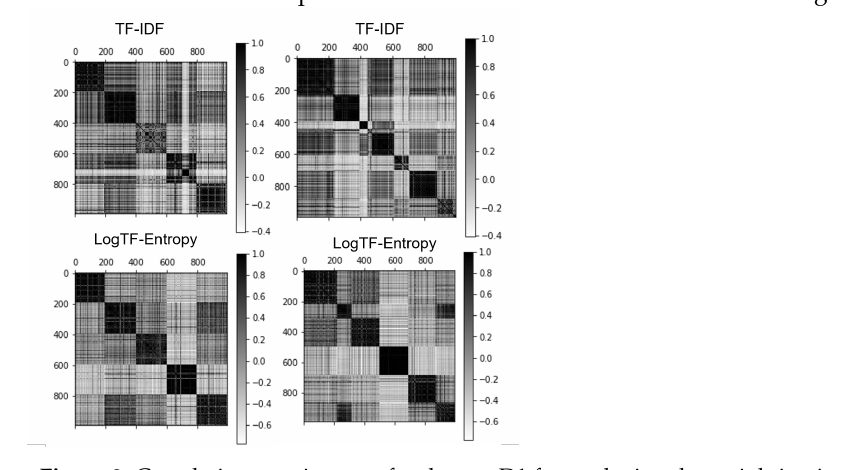
Figure 3. Correlation matrix maps for dataset D1 for analyzing the weighting impact ( left ) and the best partitions ( right